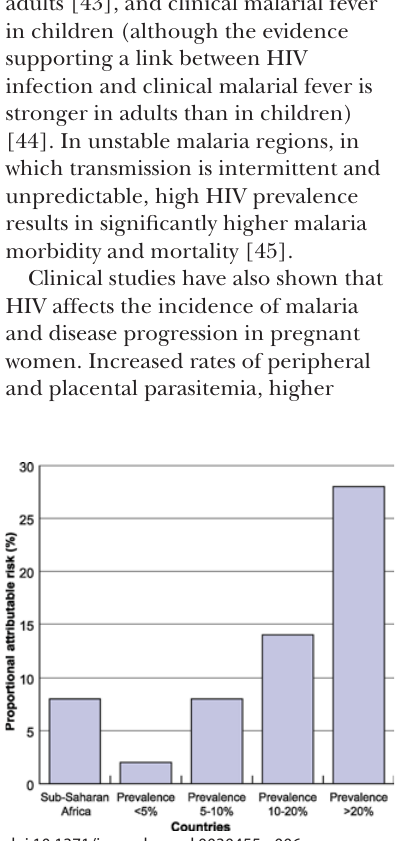
Figure 5. Cumulative Proportion of Children Dying by Mother’s HIV Status and Survival in Uganda, 1989–2000 Figure derived from [34].